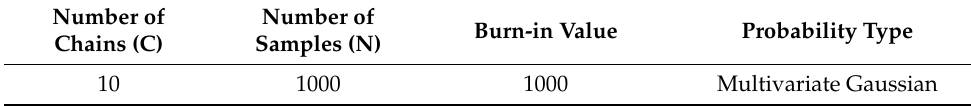
Table 3. Features of the sampling process based on the MCMC and HMC